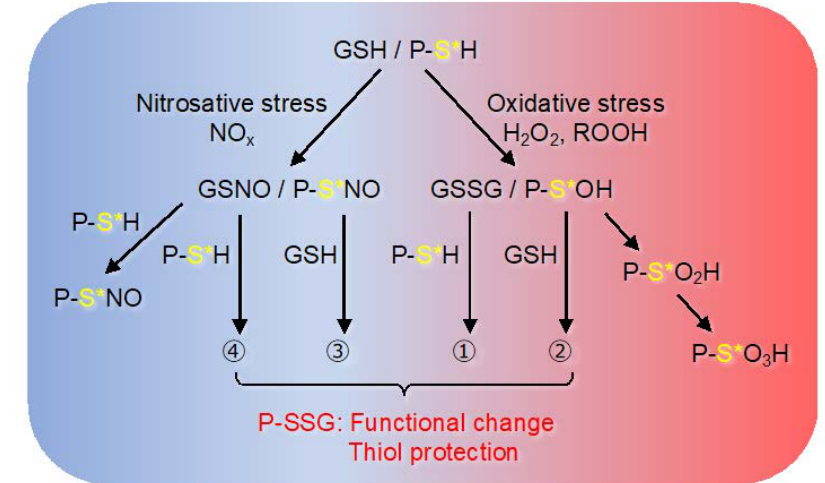
Figure 2. Oxidative / nitrosative stress-induced protein S -glutathionylation. This figure depicts oxidative / nitrosative stress-induced various mechanisms by which protein thiol moieties could be converted to S -glutathionylated protein (PSSG). (1) via thiol-disulfide exchange with GSSG; (2) via protein sulfenylation (P-SOH); (3) via protein S -nitrosylation (P-SNO); (4) via reaction with S -nitrosoglutathione (GSNO). (See the Section 2.1 in text for further explanation). Protein sulfenylation (P-SOH) is further oxidized to generate protein sulfinylation (P-SO 2 H) and protein sulfonylation (P-SO 3 H). The former is reversible and the latter is irreversible terminal modifications. Some proteins are both S -glutathionylated and S -nitrosylated by reaction with GSNO [55]. Asterisks indicate reactive cysteine thiols in a microbasic environment (low pKa) near arginine, histidine, and lysine. The figure is an image of the nitrosative (left part, shown by the blue background) and the oxidative (right part, shown by the red background)